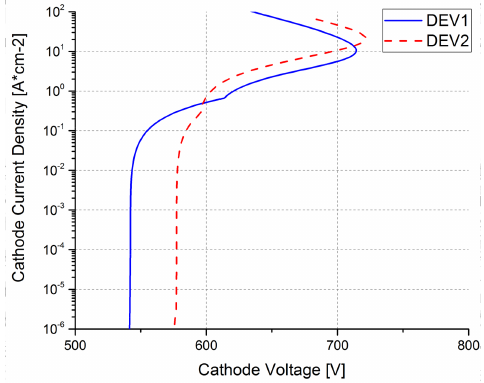
Figure 9. Termination area numerical I-V blocking curves for design DEV1 and DEV2.